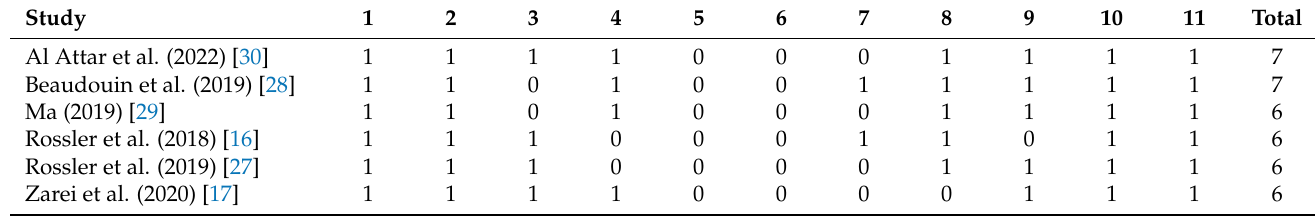
Table A3. Study quality on the PEDro scale.